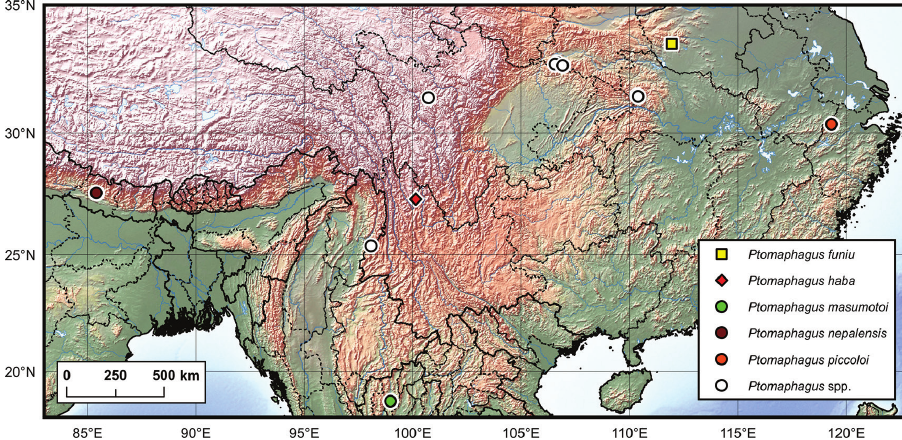
Figure 11. Distribution map of Ptomaphagus species from mainland China, Nepal, and